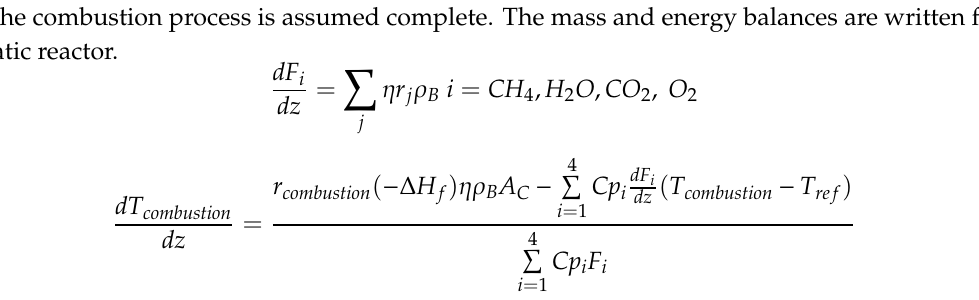
Figure 3. An elemental volume of the combustion chamber.